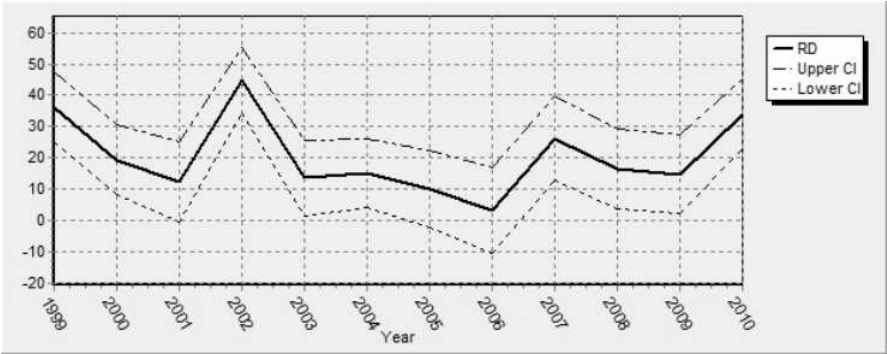
Figure 6. Trends of rate difference of age-standardised PYLL rates among women in Świętokrzyskie, years